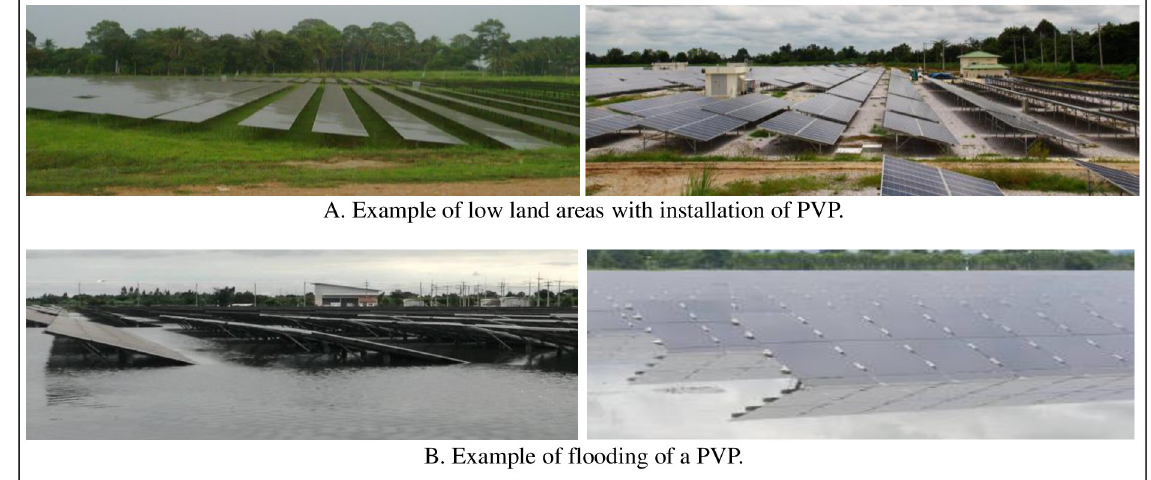
Fig 1. PVP in Thailand. A. Example of low land areas with installation of PVP. B. Example of flooding of a PVP.